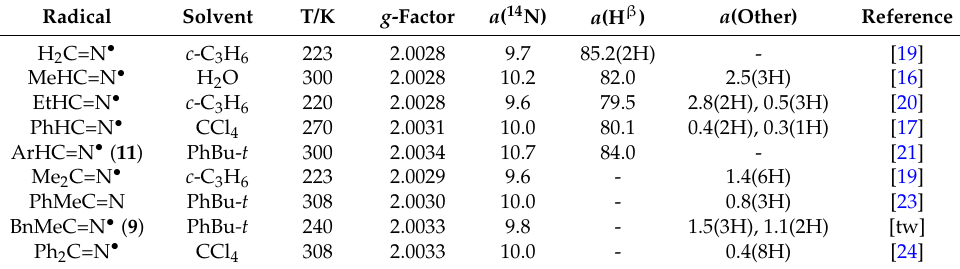
Table 1. EPR Characteristics of iminyl radicals in solution a .